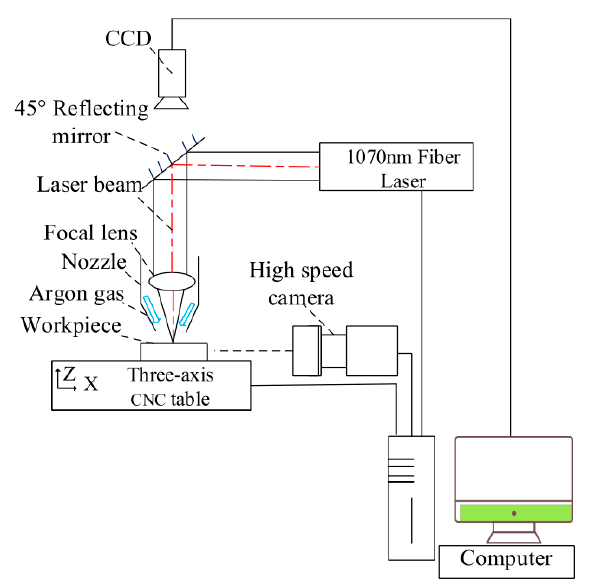
Figure 1. Schematic diagram of the experimental setup of laser drilling.